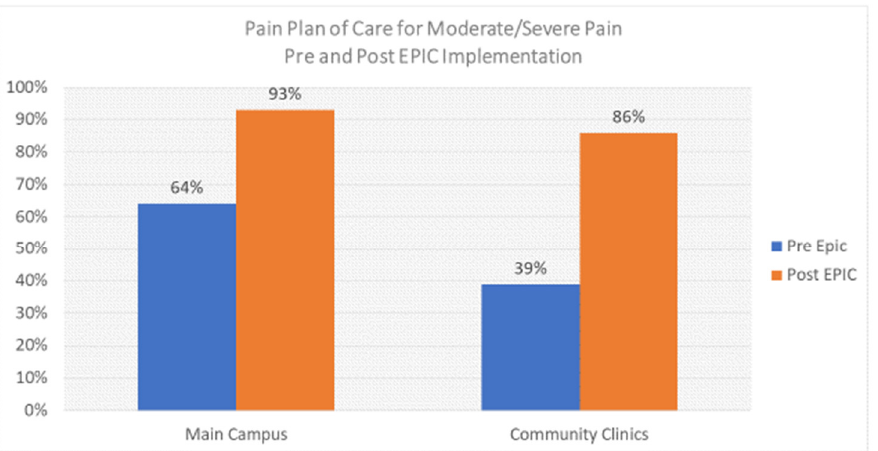
Figure 8. Pain plan of care compliance for those reporting moderate to severe pain. Blue represents results from the 3 QOPI reporting quarters (Fall 2016, Spring and Fall 2017) from the previous EHRs (Allscripts on campus and TouchWorks in community sites) prior to the EPIC implementation. Orange represents results from the 4 QOPI reporting quarters (Spring and Fall 2018 and Spring and Fall 2019) after the December 2017 EPIC transition for both the campus and community sites.